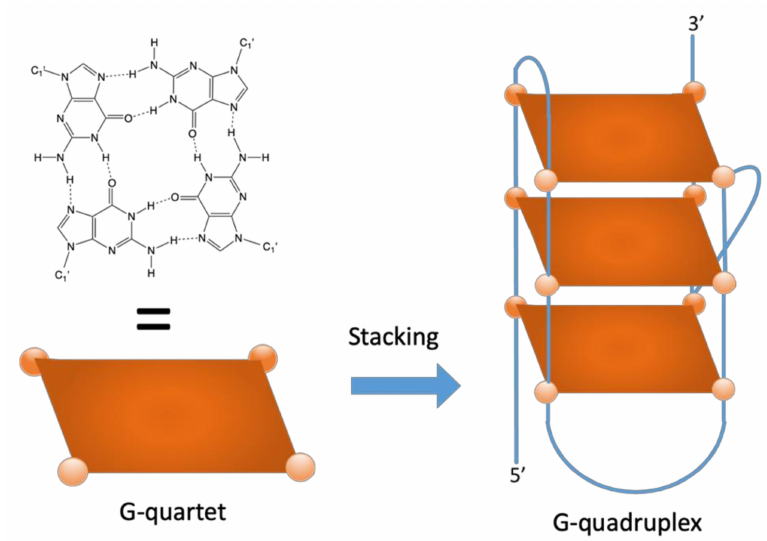
Figure 2. A G-quartet involves four coplanar guanines establishing a cyclic array of H-bonds (left). Stacking of two or more (three in this example) quartets leads to the formation of a G-quadruplex structure (right), stabilized by cations, such as potassium (not